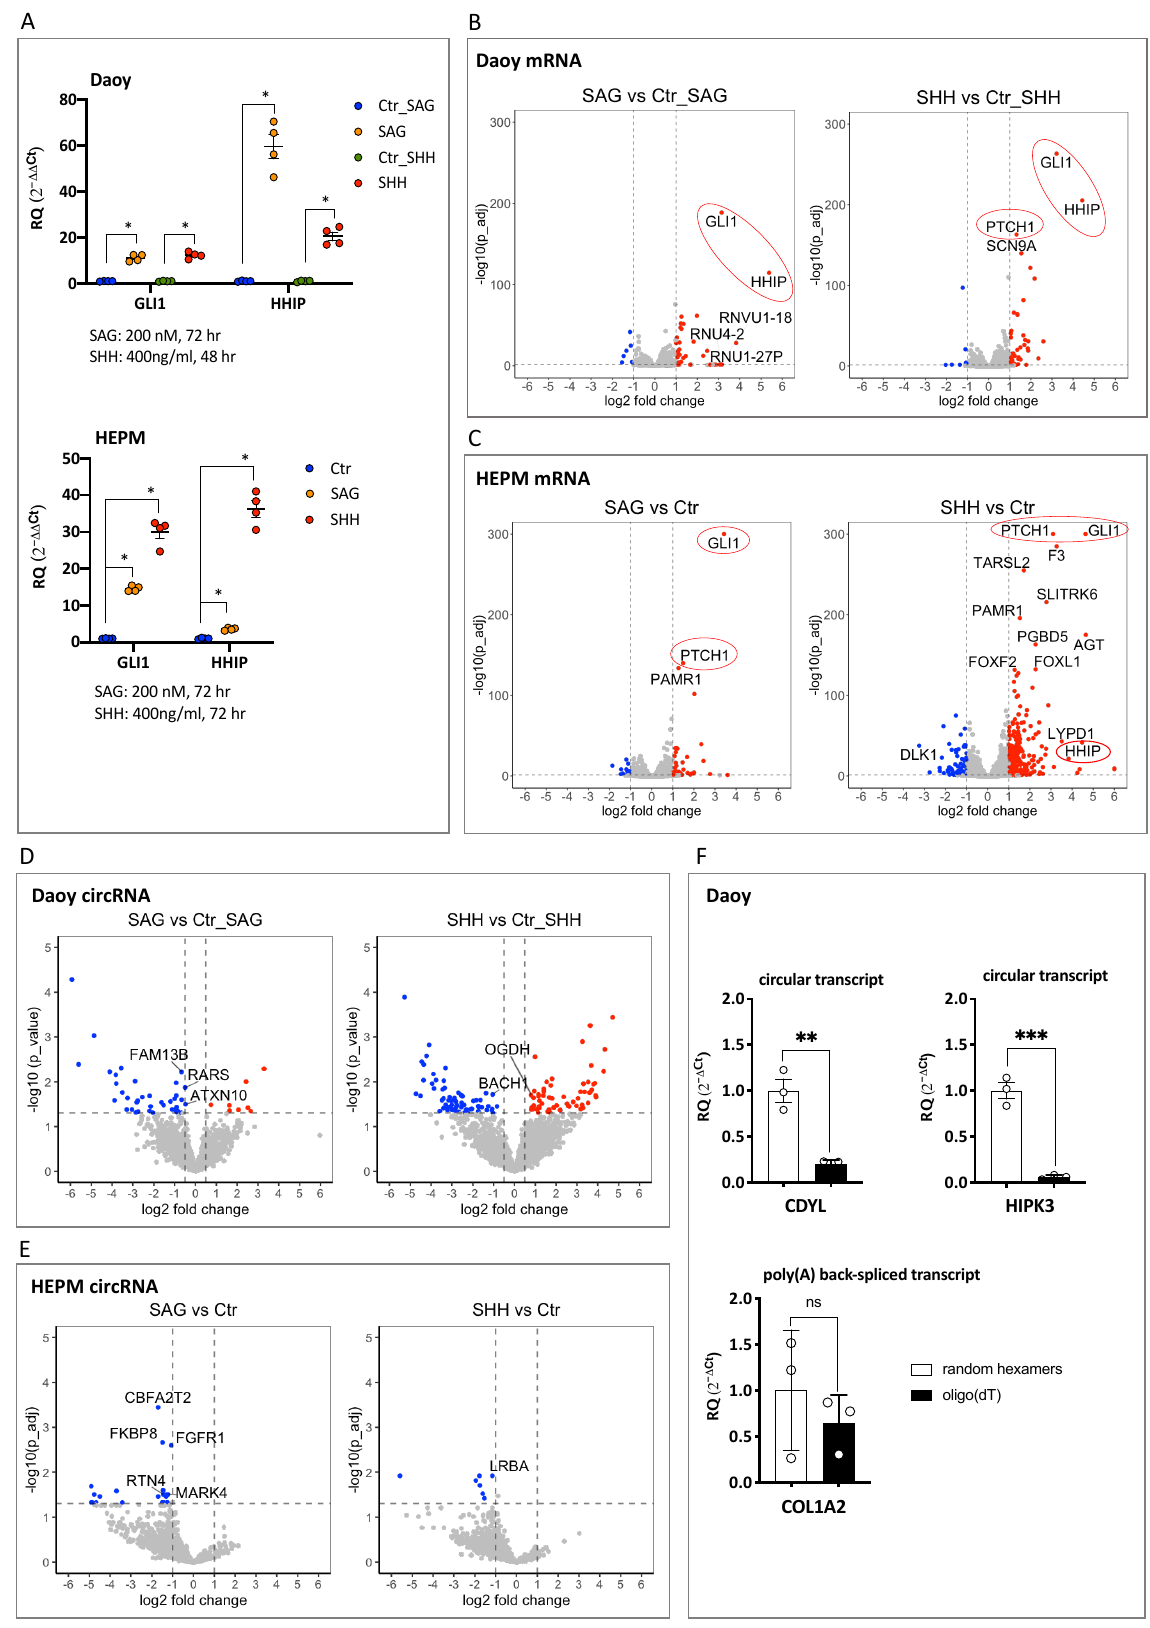
Figure 1. circRNAs regulated by Hedgehog signaling activation in human medulloblastoma Daoy and human embryonic palatal mesenchyme HEPM cell lines: ( A ) qPCR analysis of Hedgehog target gene expression. The relative expression (2 − ∆∆ Ct values), normalized to the housekeeping gene (TBP) and the control treatment (DMSO for SAG and PBS for SHH